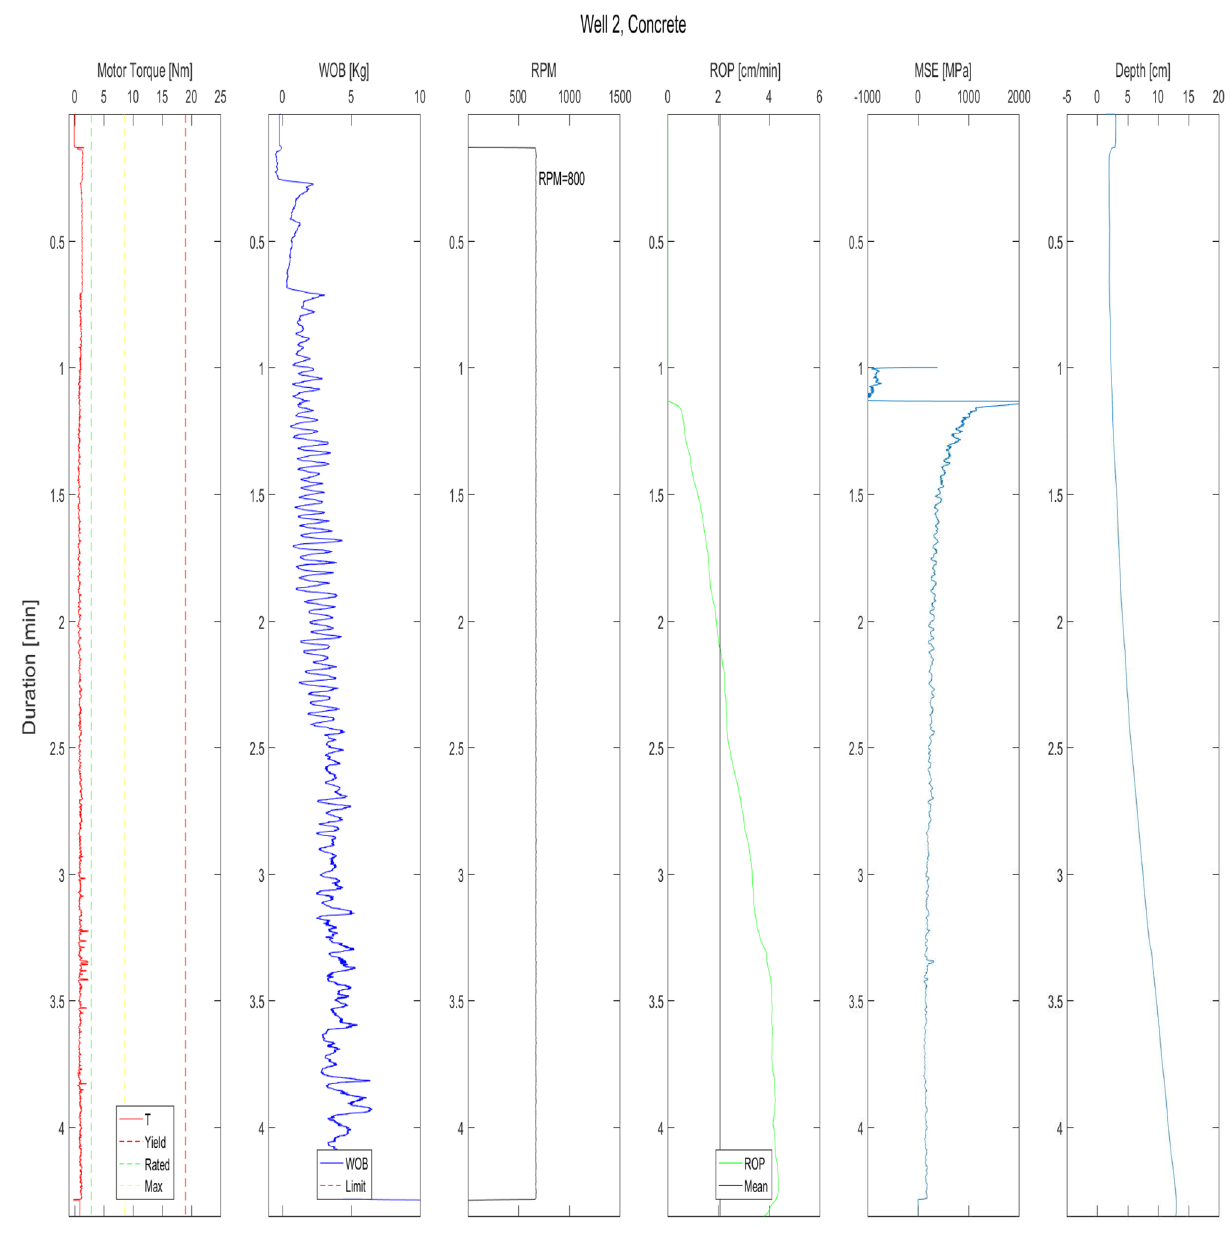
Fig. 11 Well Concrete 2, manual mode with varying WOB, RPM =